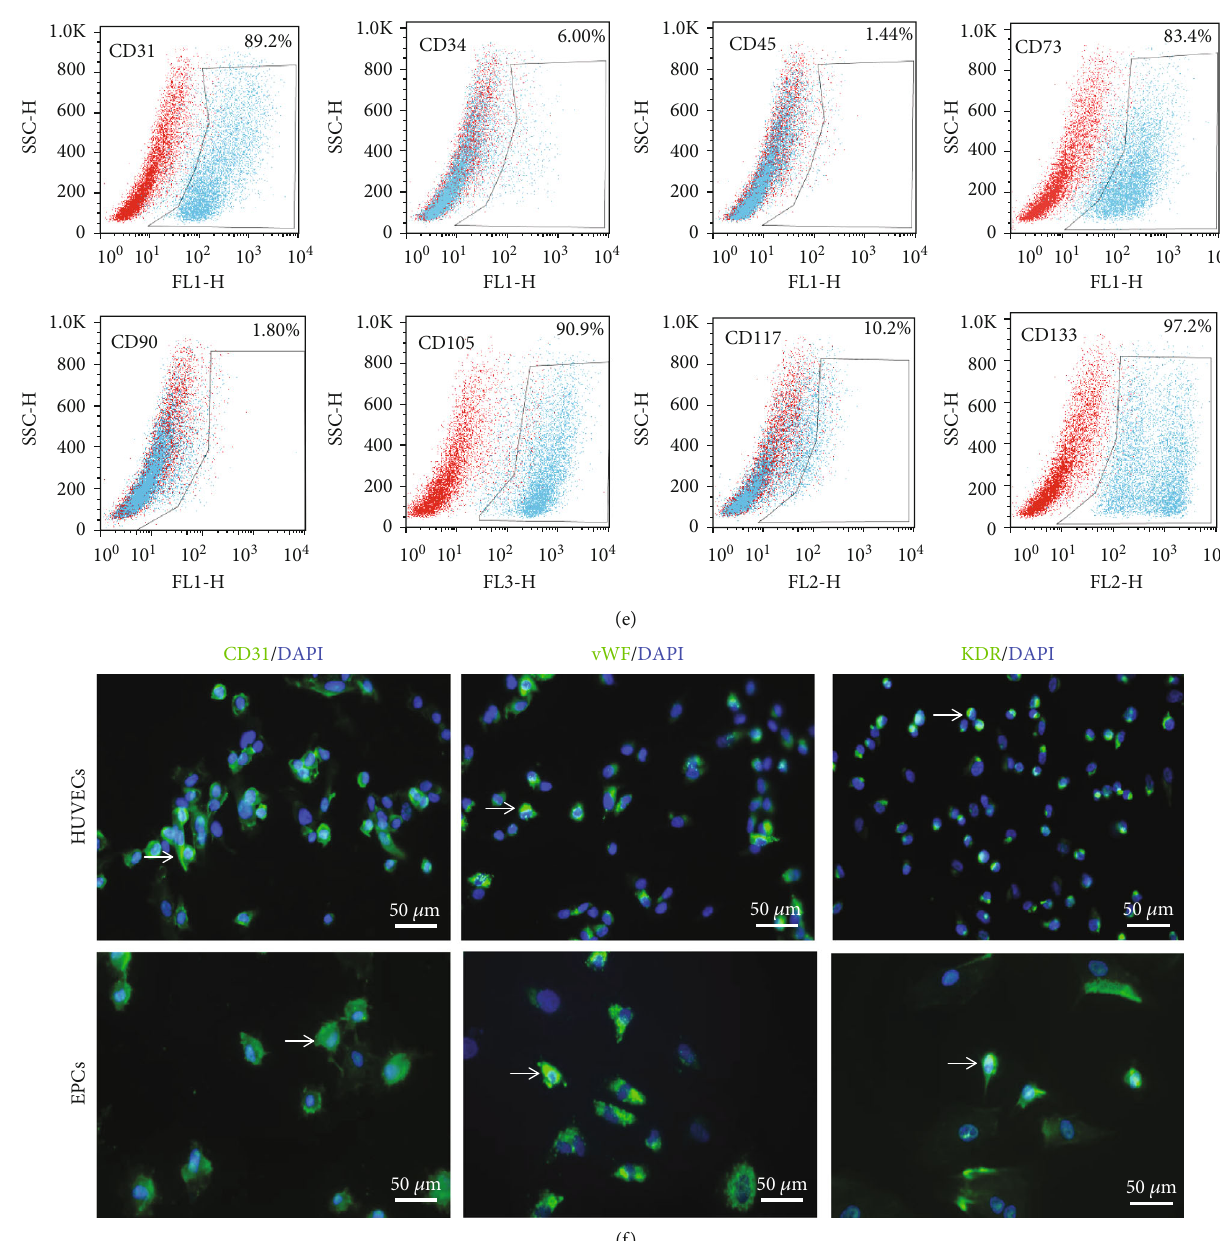
Figure 1: Characterization of cultured ADSCs and EPCs. (a) The adherent cultured rat ADSCs exhibited fi broblast-like morphology ( × 100) (b) Flow cytometry analysis demonstrated these ADSCs was strongly positive for CD73, CD90, and CD105. (c) The ELISA assay showed that ADSCs could secrete a large amount of VEGF and SDF-1 in vitro. (d) The cultured EPCs exhibited the typical cobblestone-shaped appearance ( × 100). (e) Flow cytometry analysis demonstrated these EPCs were strongly positive for CD31, CD73, CD105, and CD133. (f) Immuno fl uorescence staining con fi rmed that EPCs were positive for EC markers CD31, vWF, and KDR. Scale bars: 50 μ m. VEGF: vascular endothelial growth factor; SDF-1: stromal cell-derived factor-1; vWF: von Willebrand Factor; KDR: kinase insert domain